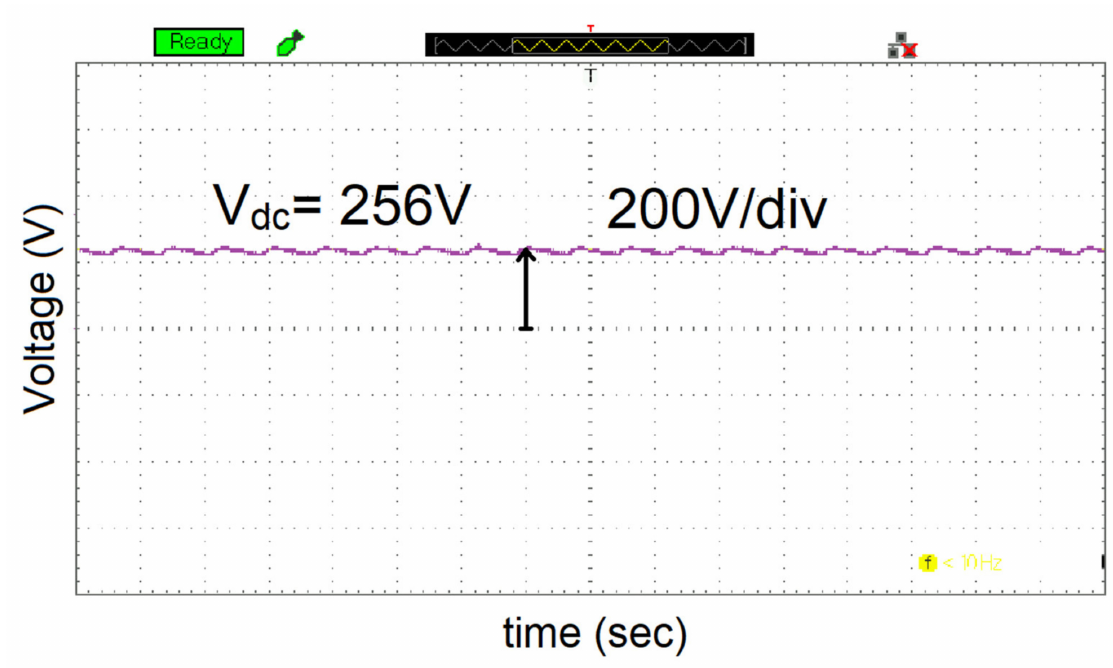
Figure 24. Output voltage of a DAB